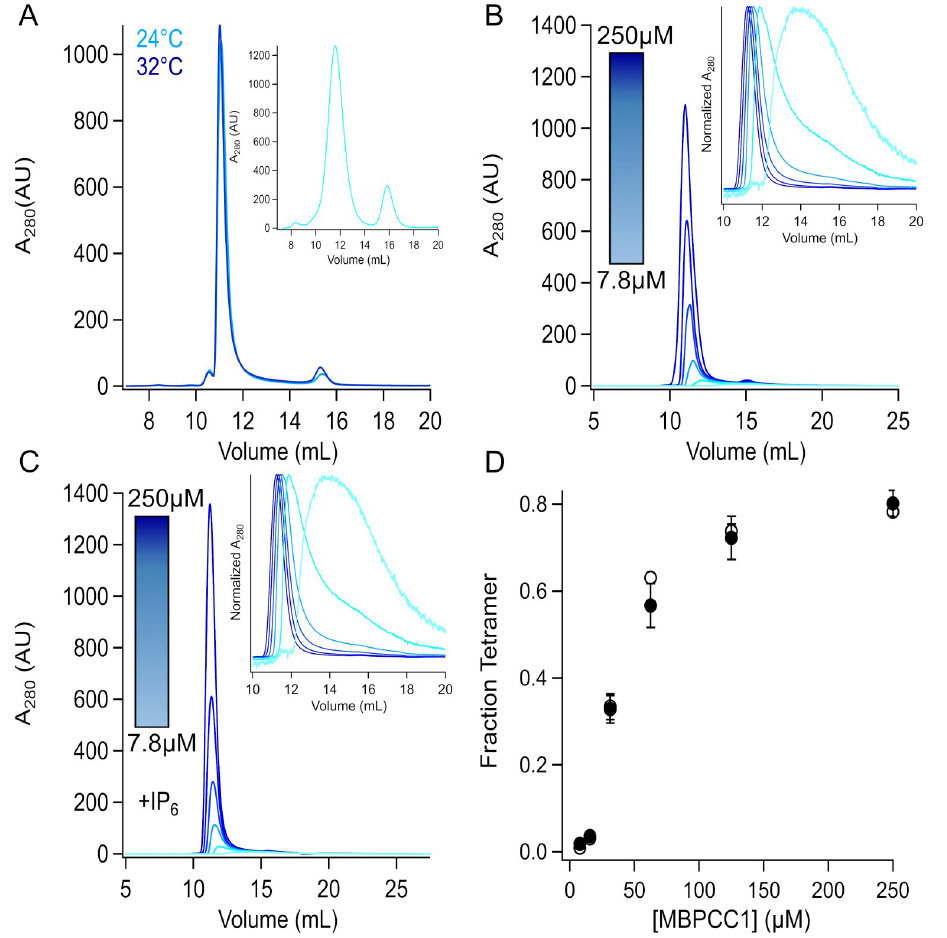
Fig 4. Concentration, not temperature or IP6, is the primary driver of tetramerization. A. SEC chromatograms of MBPCC1 at 4˚, 24˚, and 32˚C. The instrument and column for T = 24˚C and T = 32˚C were the same (Superdex 200 Increases run on a Shimadzu system), but different from sample injected at 4C (Superdex 200 column and Akta Explorer). Both peaks are at molecular weights consistent with tetrameric protein at all temperatures tested. B and C. Protein at different concentrations (250 μ M, 125 μ M, 62.5 μ M, 31.25 μ M, 15.625 μ M, and 7.8125 μ M) was injected at 24˚C in the absence (B) and presence (C) of IP6. Insets show the normalized absorbance to highlight the shift in elution volume at lower concentrations. (D) Fraction of tetramer vs concentration (n = 3 for each concentration).